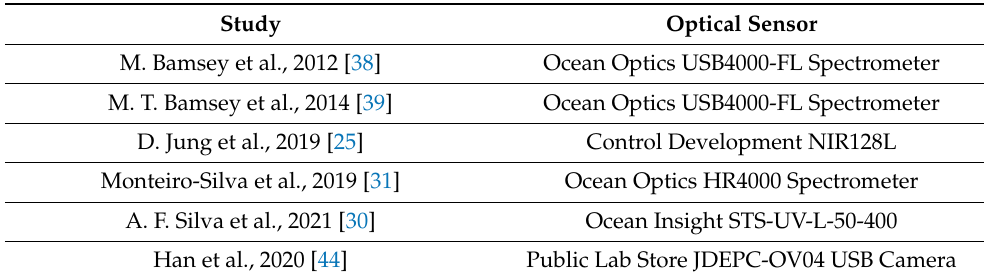
Table 1. Literature on applied spectroscopy for monitoring hydroponic nutrient